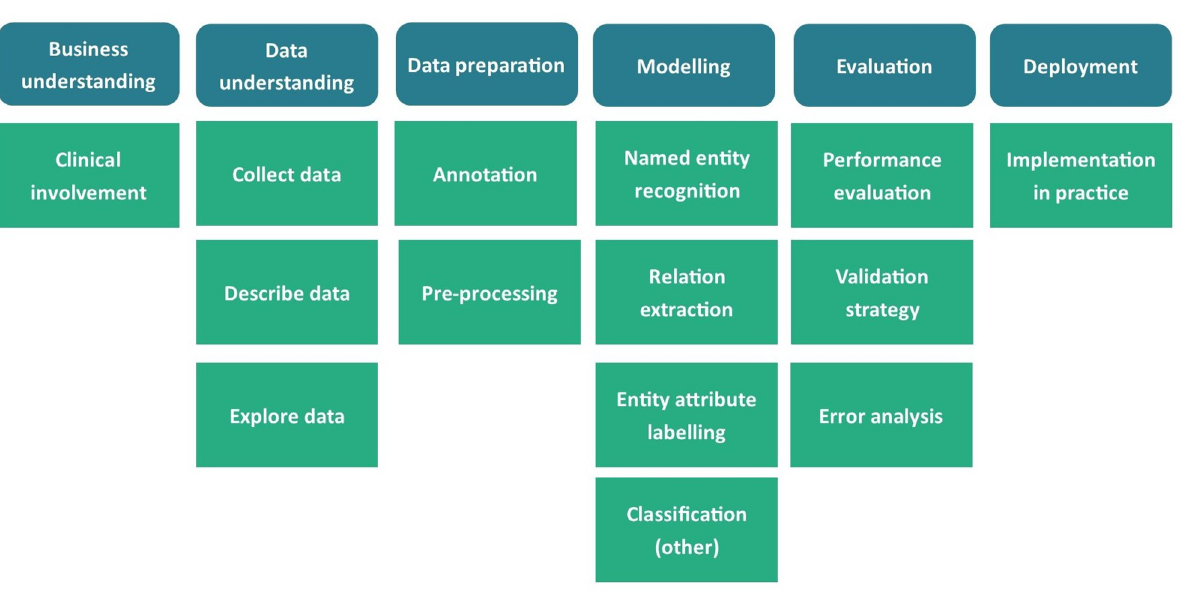
Fig 2. A framework for NLP workflow in clinical setting according to CRISP-DM reference model [18].